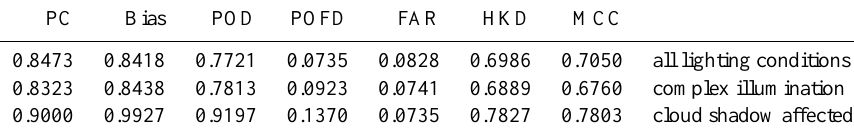
Table 3. Results of the visual validation. PC Bias POD POFD